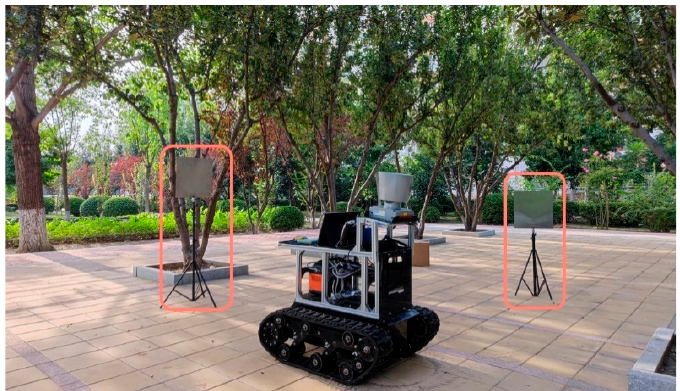
Figure 9. Verification experiment in agriculture scene.